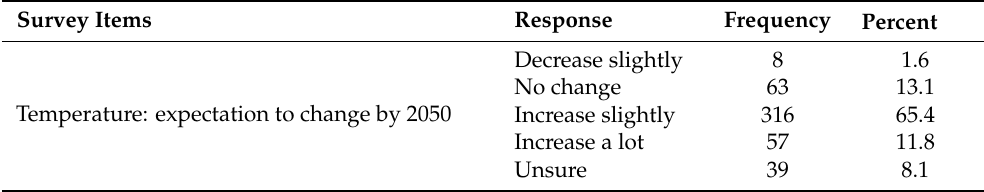
Table 4. The 2017 survey of rural decision makers’ item-and-response options covering small-to medium forest owners (Source: Brown